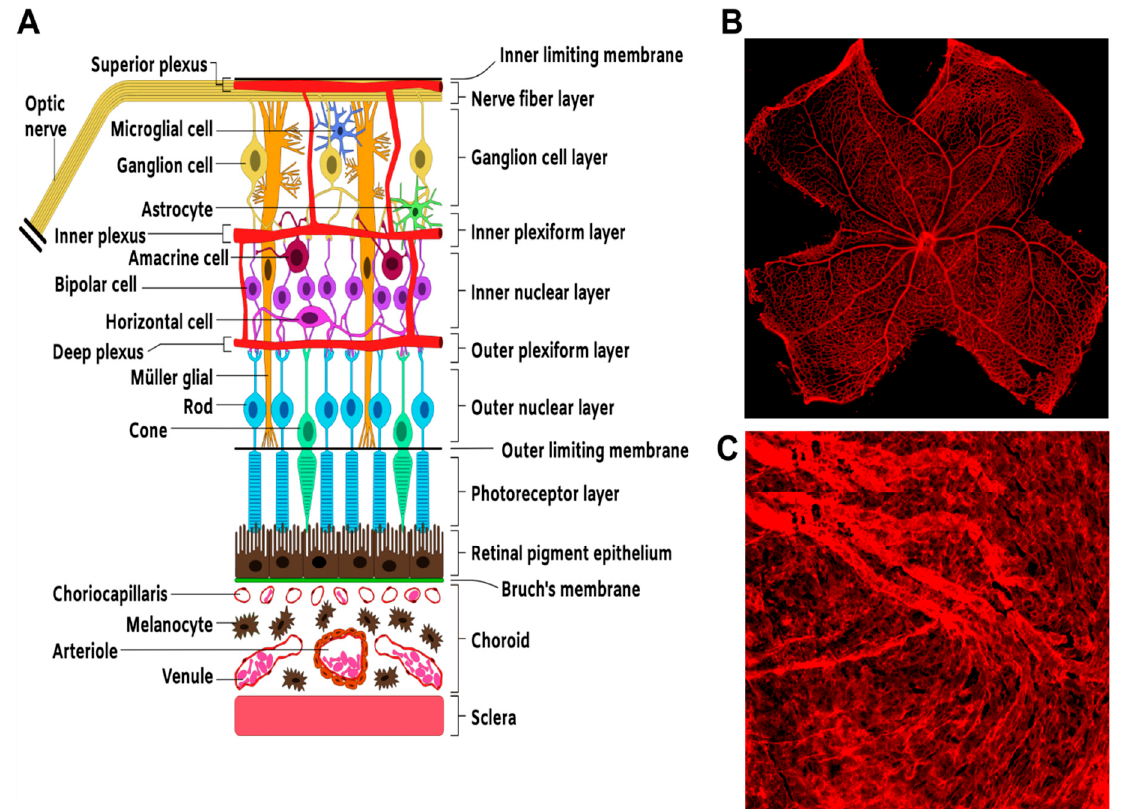
Figure 1. Structure and organization of the neural and vascular retina. ( A ) Schematic. Representation of section of the retina showing the overall arrangement of retinal neural layers and the basic vascular circuitry. ( B ) Flat mount preparation of a mouse retina showing IB-4-stained retinal vasculature. ( C ) Flat mount preparation of IB-4-stained choroidal vasculature.